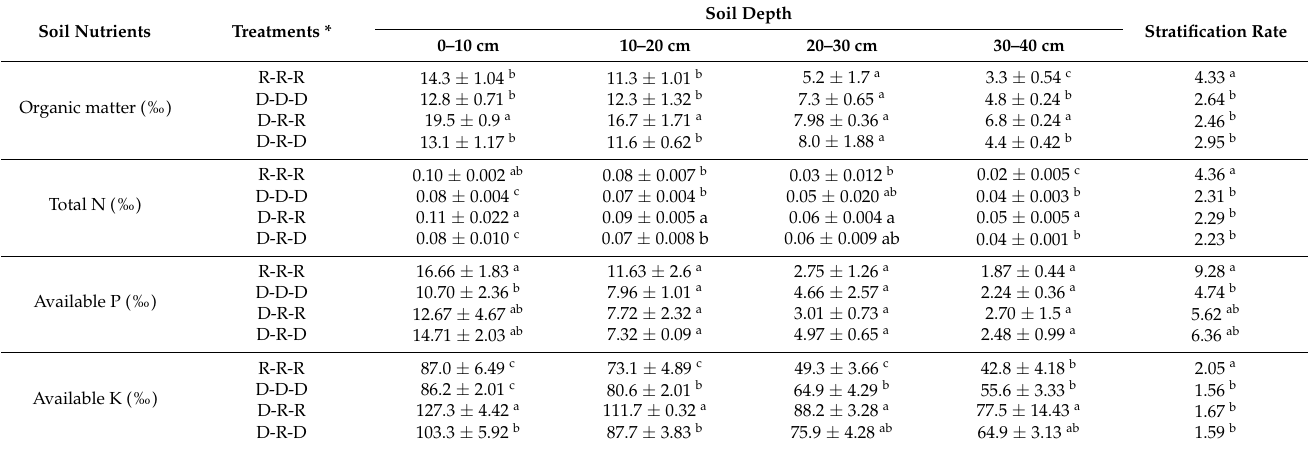
*: R representing rotary tillage, D representing deep tillage, and their arrangements representing the different combinations in each year. Different lowercase letters in the same column mean significant differences among treatments at 0.05 level. LSD test: p <